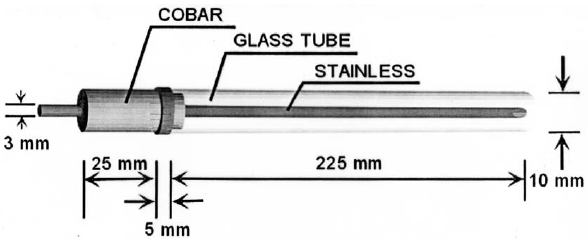
Fig. 1. Diagram of glass-sealed Langmuir probe sensor “support rod”, which is mentioned in Fig. 2a, and made of COVAR (25mm in length, and 10mm outer Fig 1. Cartoon of Glass sealed Langmuir Probe “Support rod” which is mentioned in Fig2a is made of COVAR (iron-nickel alloy, 25mm in length, and 10mm outer diameter).